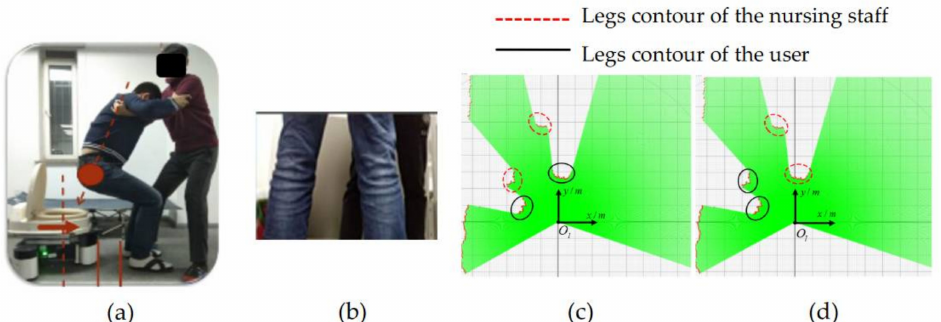
Figure 2. Leg detection and target recognition. ( a ) Standing patterns in the transfer process of assisting excretion. ( b ) Leg occlusion in real scene. ( c ) Misrecognition of standing patterns. ( d ) Distribution of real standing